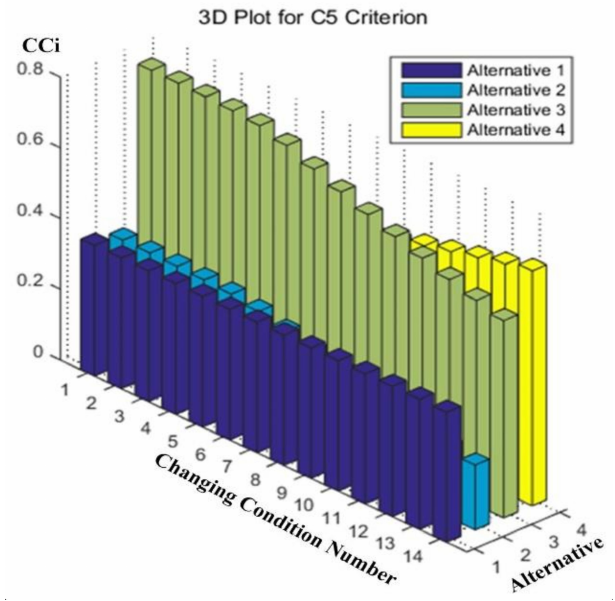
Figure 9. 3D histogram plot for performance changes in C5 main changing